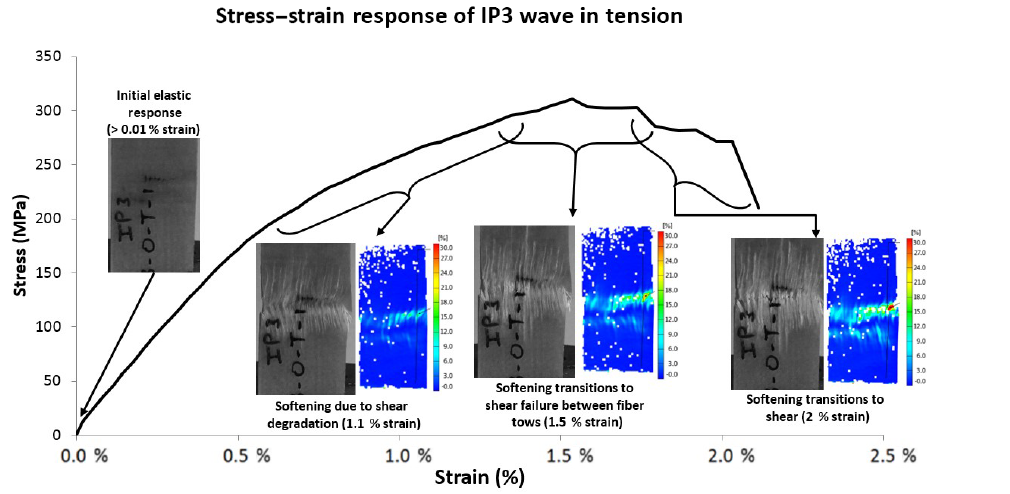
Figure 11. Stress–strain response of IP3 wave coupon shown at increasing average full field strain with associated DIC strain fields identi- fying damage progression.